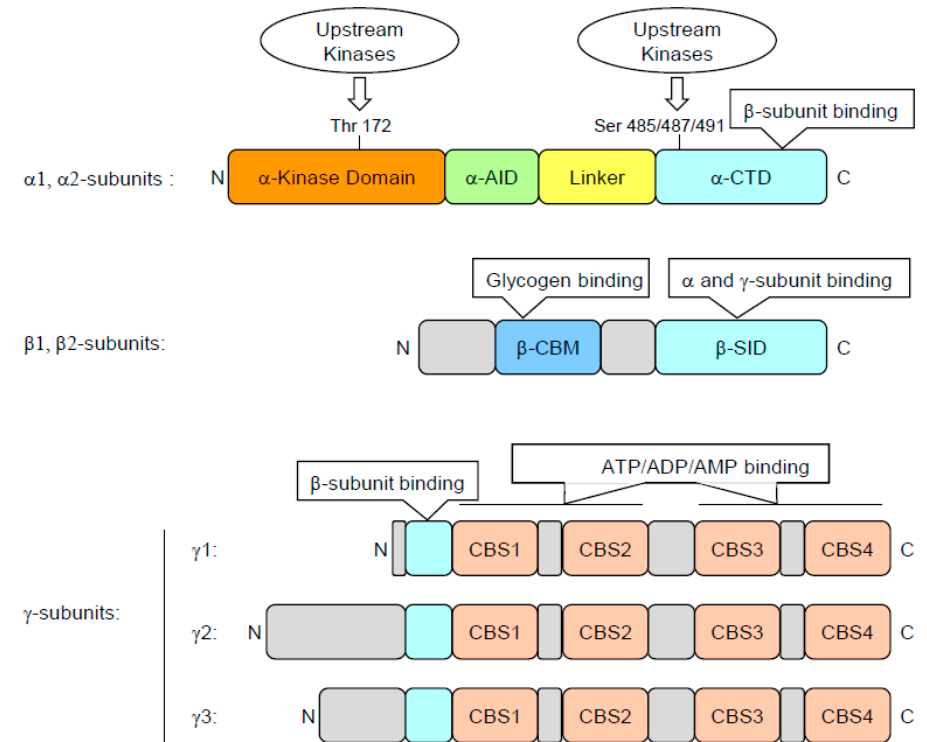
Figure 1. Structure of mammalian AMPK subunits. AMPK is a heterotrimeric protein consisting of 1 catalytic subunit ( α subunit) and 2 regulatory subunits ( β and γ subunits). The α subunit contains a kinase domain ( α -KD), the activity of which relies on the phosphorylation of Thr172 by upstream AMPK kinases. The kinase domain is followed by an autoinhibitory domain ( α -AID) that is joined to the COOH-terminal domains ( α -CTD) by a less well conserved linker. The α -CTD domain binds to the C-terminal domain of the β subunit. The β -subunit contains two conserved regions: (1) a carbohydrate-binding module ( β -CBM) that causes the mammalian complex to bind to glycogen particles and (2) a COOH- terminal subunit interaction domain ( β -SID) that provides the bridge between the α - and γ -subunits. The γ -subunit contains variable NH2-terminal regions followed by a short sequence involved in binding to the β -subunit and by four tandem repeats of a cystathionine- β -synthase (CBS) motif that act in pairs to form the binding sites for adenine nucleotides (ATP, ADP and AMP).